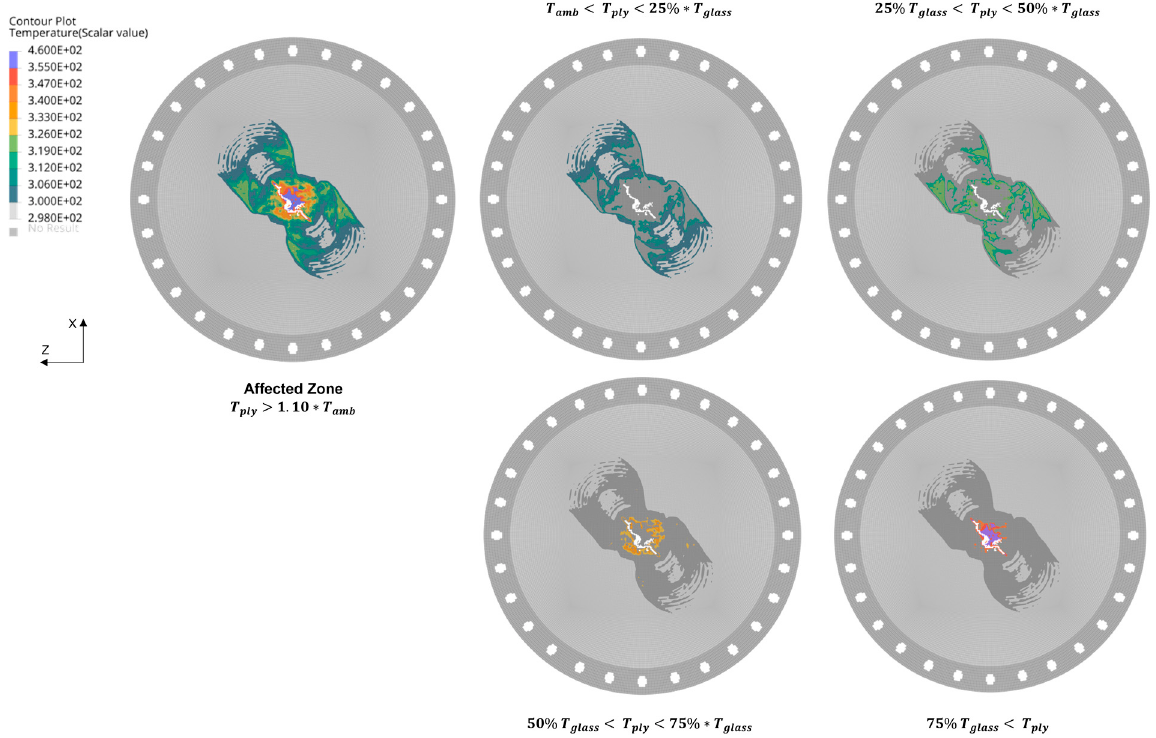
Figure 12. Principal temperature ranges of selected composite ply (P7) at 0.2 ms in comparison to a glass temperature threshold (Unit Kelvin).